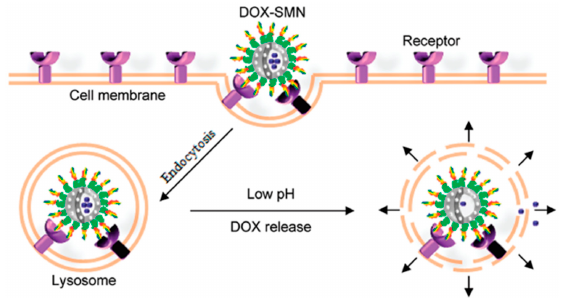
Figure 12. Schematic illustration of SMNs for targeted cancer chemotherapy. Owing to surface coating of aptamers, DOX-SMNs specifically enter target cancer cells through receptor-mediated endocytosis and reside in acidic lysosomes. Reprinted with permission from Reference [76]. © (2011) American Chemical